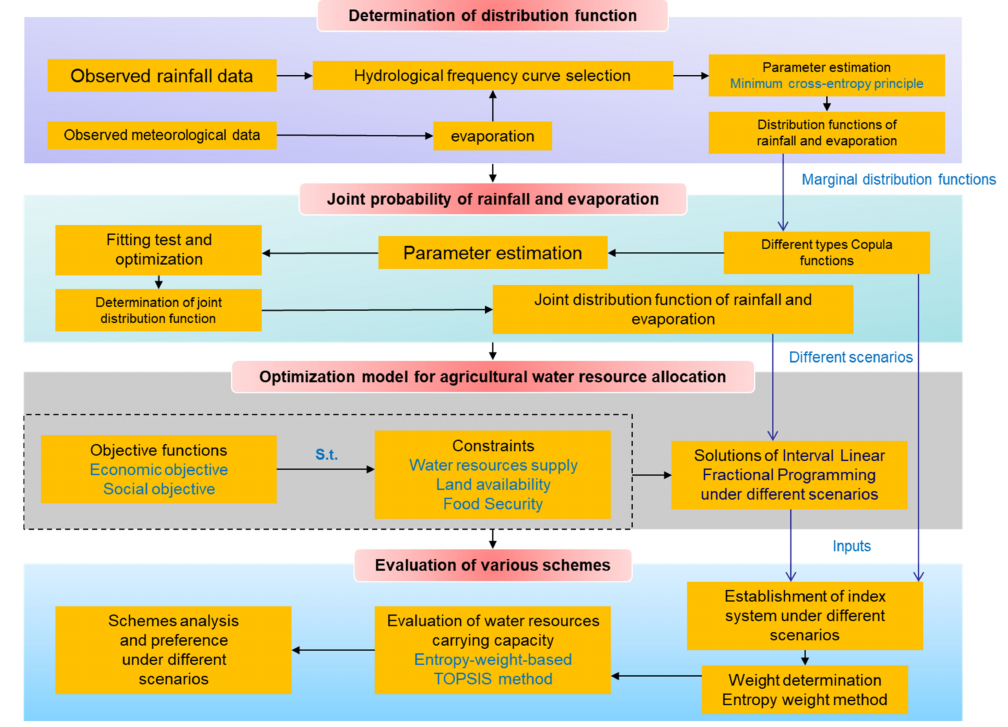
Figure 1. Decision-making framework of resource management for the Hetao Irrigation